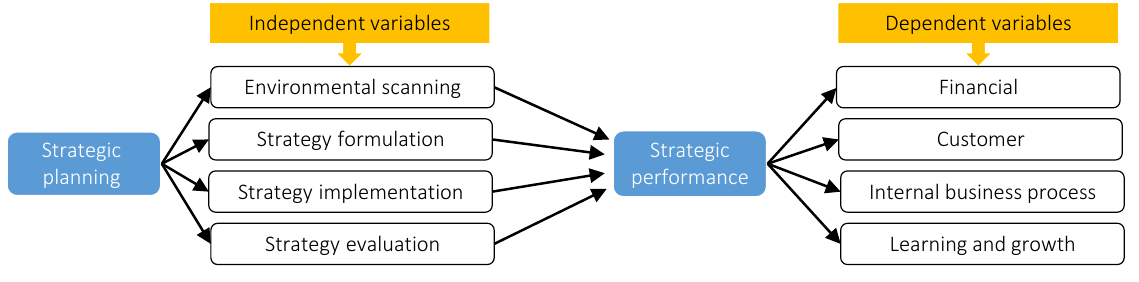
Figure 1. Research